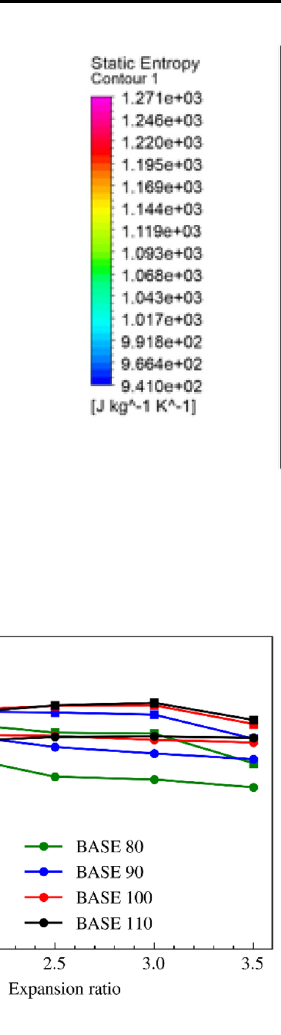
Fig. 16 Efficiency of OPT and BASE at off-design